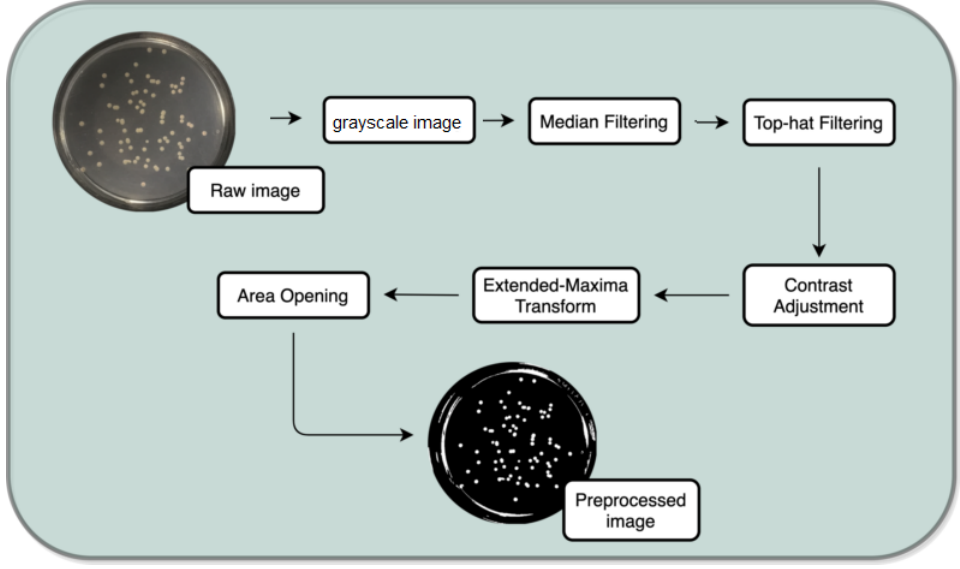
Figure 4. Preprocessing